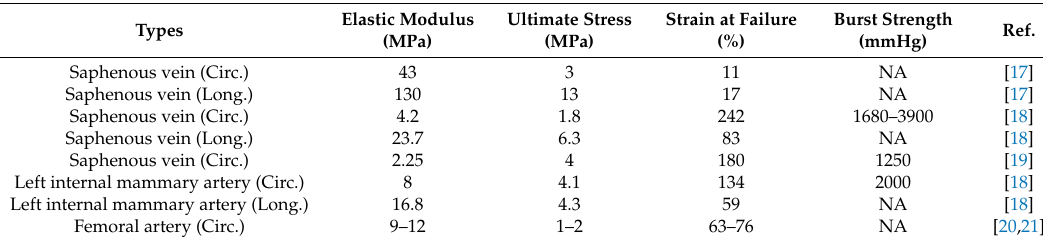
Table 1. Mechanical properties of natural blood vessels.